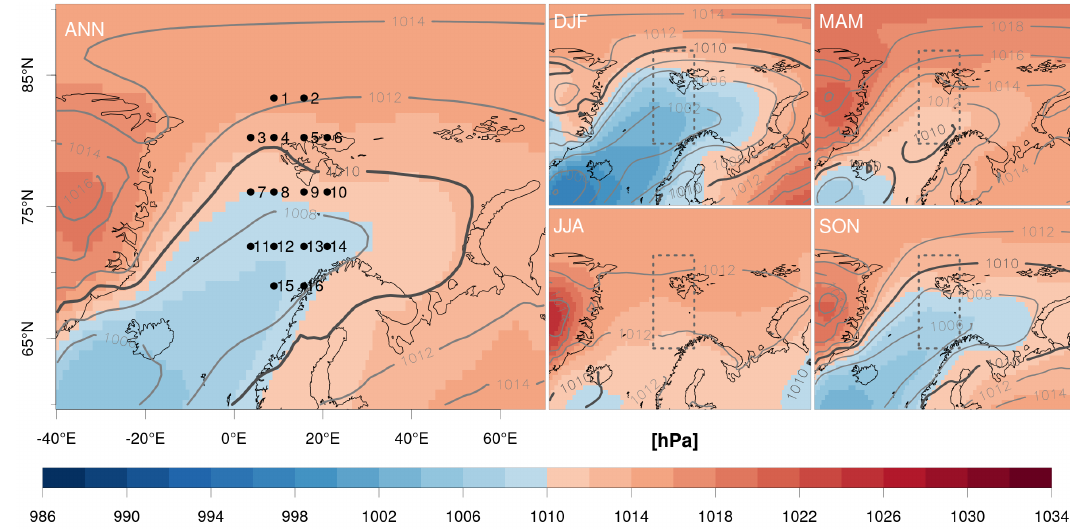
Figure 2. Annual and seasonal mean sea level pressure from ERA-Interim (1979–2008, as contour lines) and the current climate MPI-ESM-LR simulation (1971–2000, in colours). The numbered points and dashed box denote the grid points and bounding box used for the weather type classification, respectively. The labels in the top left corners refer to the annual mean (ANN) or the months of the specific season of the